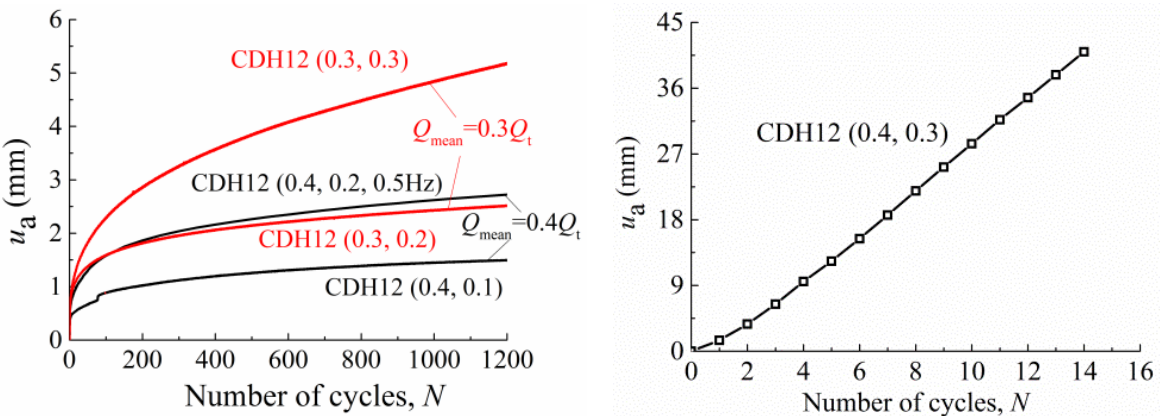
Figure 10. Developments of accumulated displacement under different amplitudes.